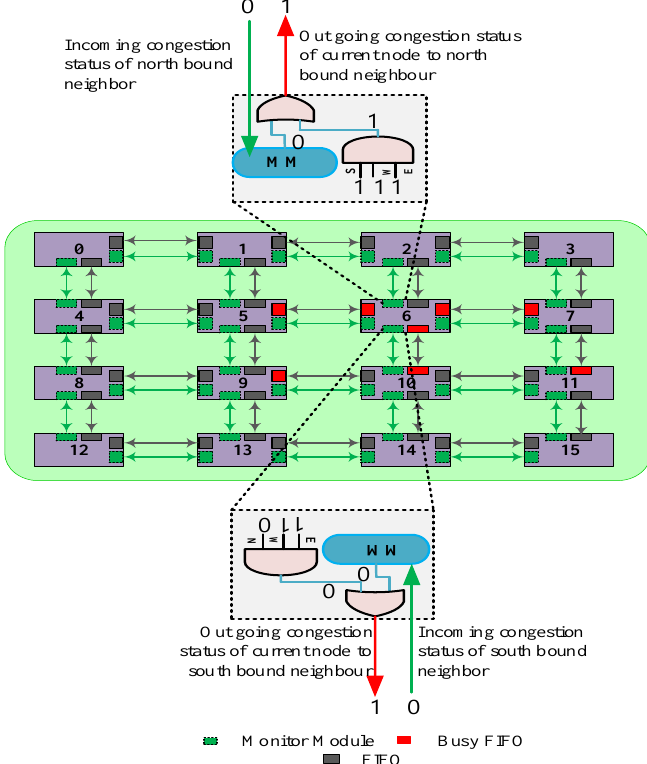
Figure 6. Modified EMBRACE behavior for avoiding congested regions.